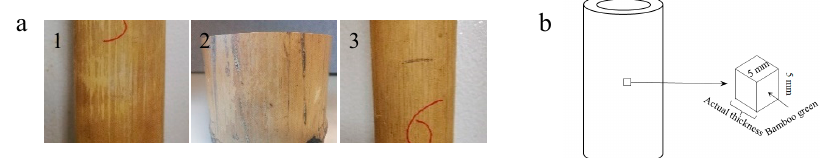
Figure 1. Bamboo specimens: ( a ) bamboo blocks, ( b ) bamboo specimen preparation.